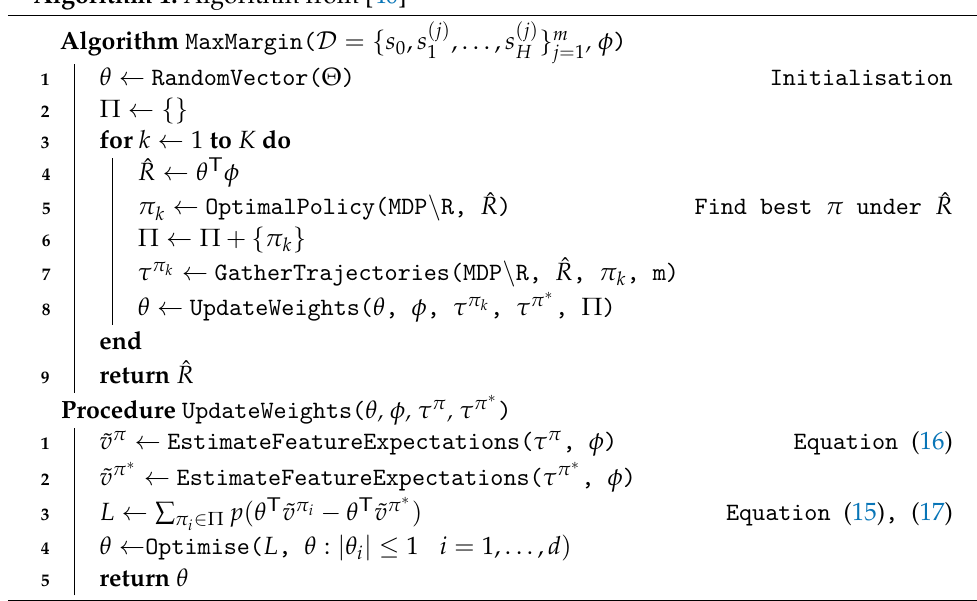
Algorithm 1: Algorithm from